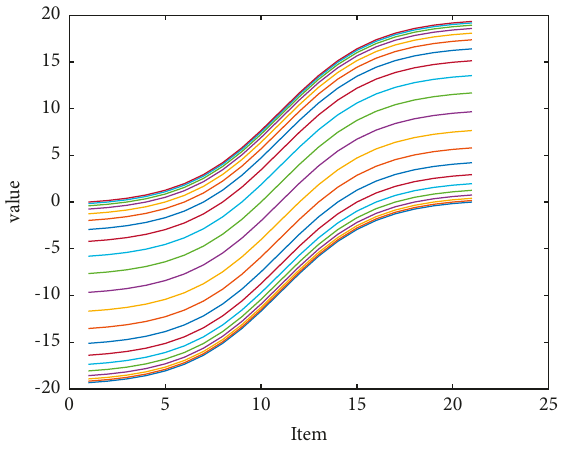
Figure 4: Predicted